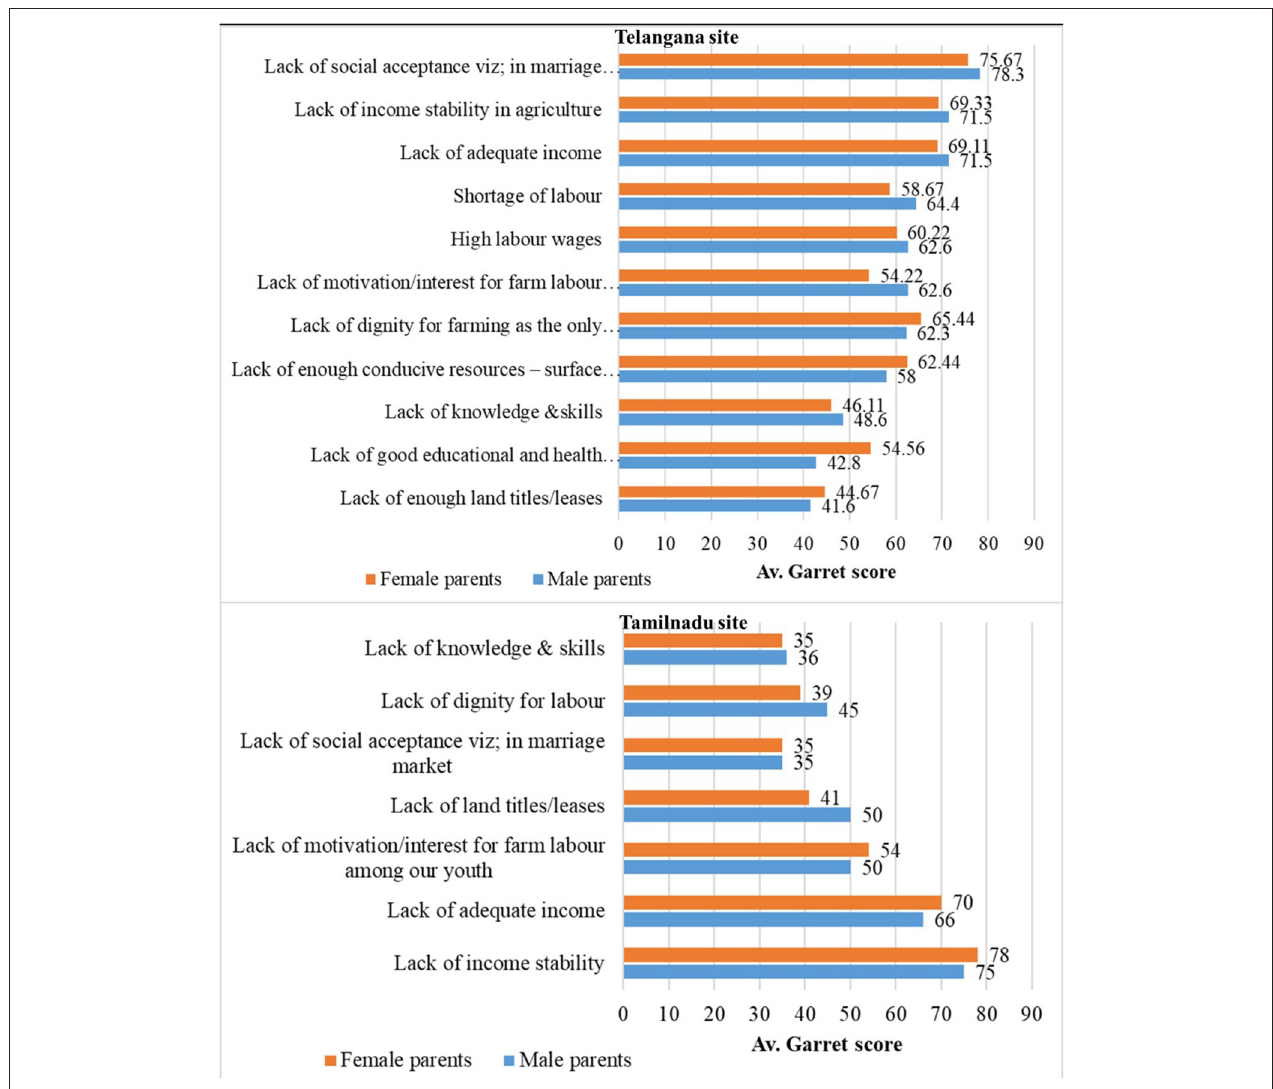
FIGURE 4 | Farm parents’ perceptions of challenges to continue